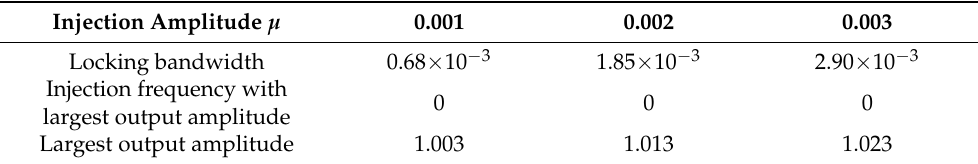
Table 2. Comparison of injection locking in different injection